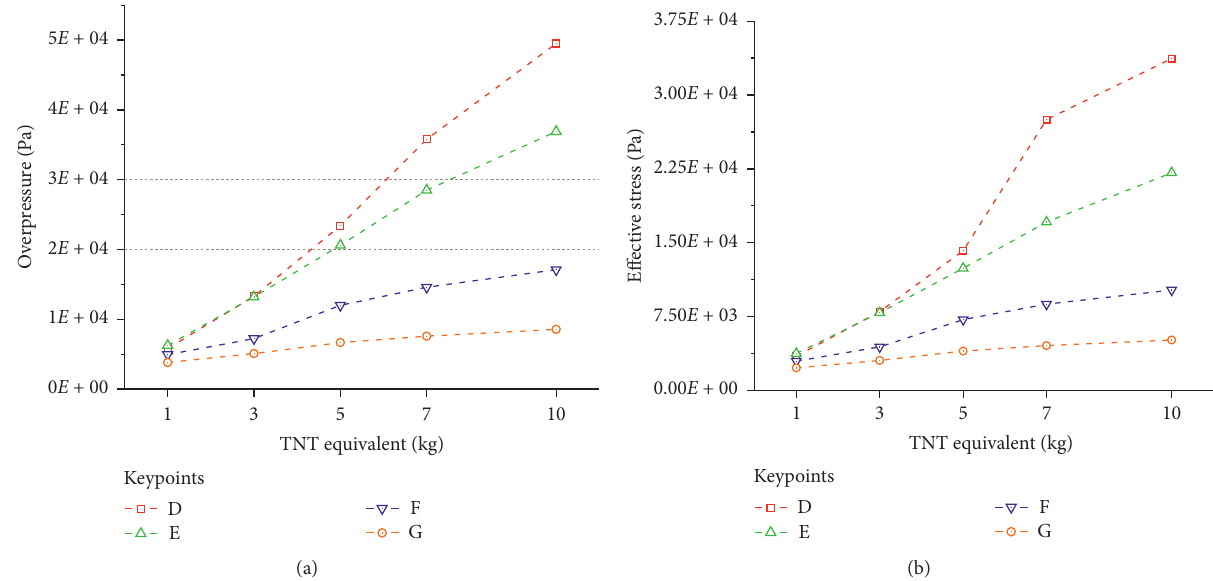
Figure 14: Dynamic response curves of pavements under different TNT